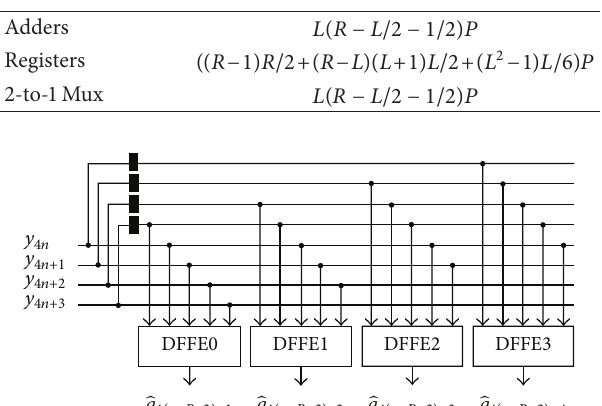
Table 1: Complexity of the parallel DFFE architecture for 2 -PAM and 𝑅 > 𝐿 .